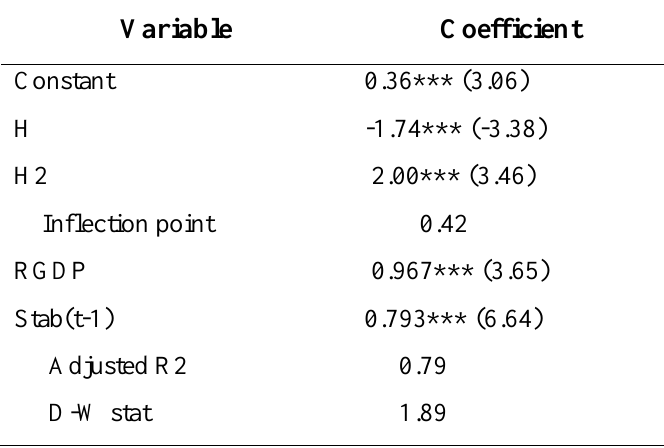
Table 4: Regression results of stability model-Equation